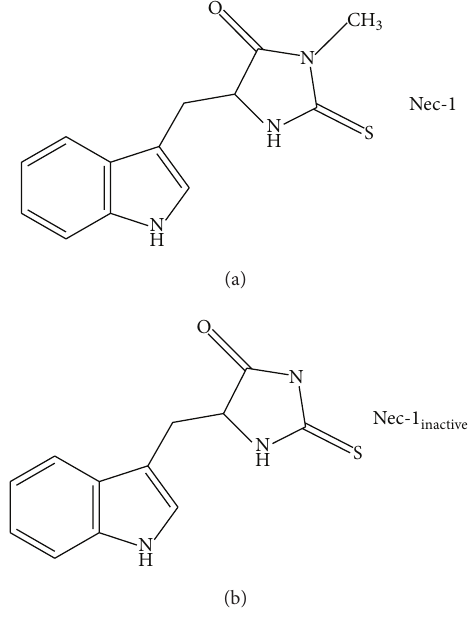
Figure 1: Chemical structures of Nec-1 and Nec- 1